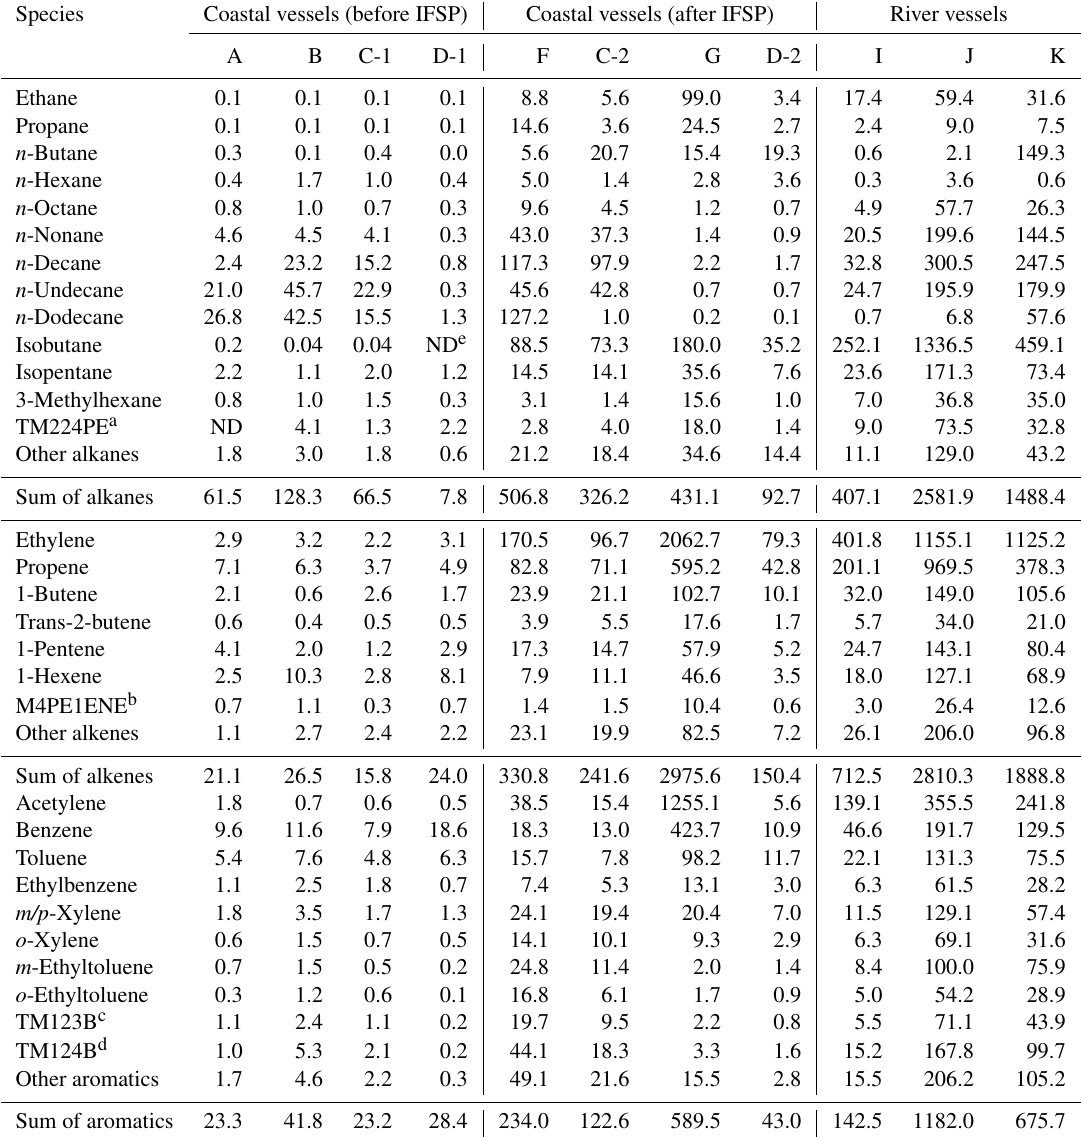
Table 4. Emission factors (mgkg − 1 ) of VOCs for test vessels.